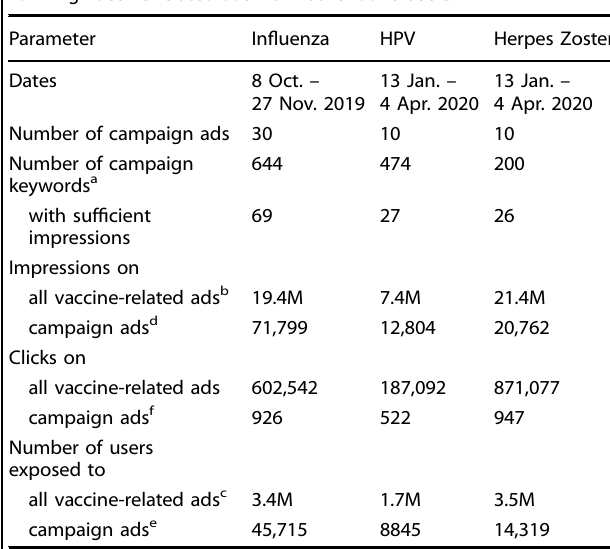
Table 1. Statistics of the advertising campaign and of concurrently running vaccine-related ads from other advertisers.